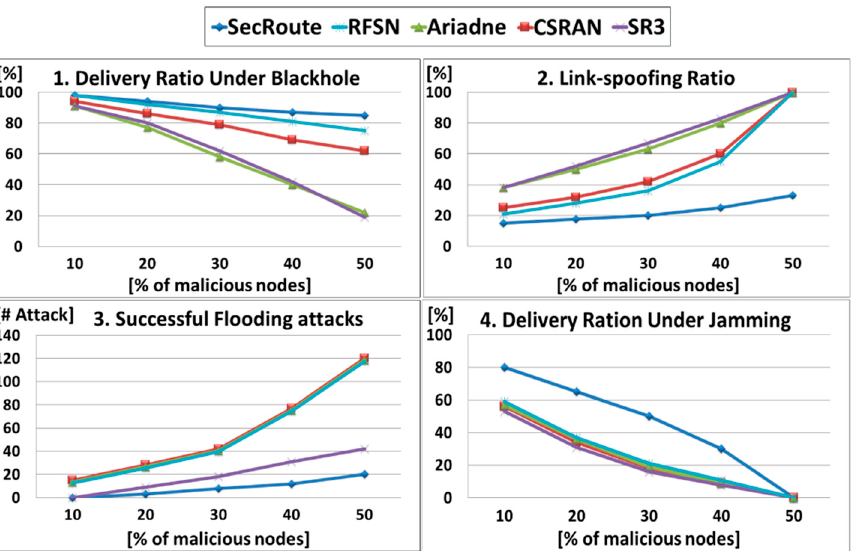
Figure 3. Simulation results for the evaluation of the network layer security solutions against four attack scenarios.